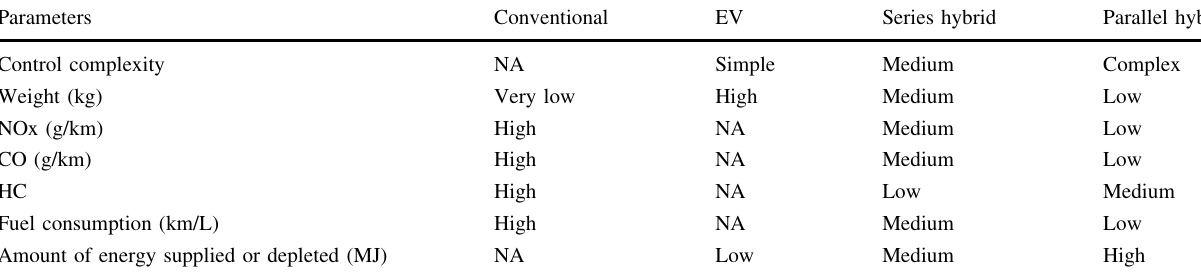
Table 3 Comparison of emission for different driving cycles [29] Parameters